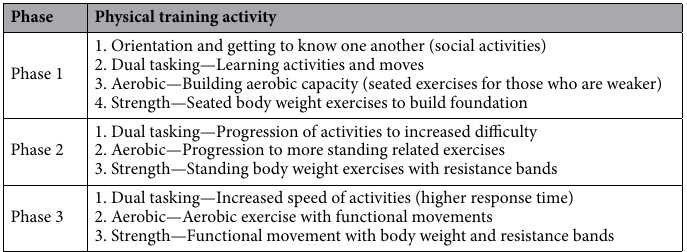
Table 1. Description of physical training protocol. Progression of phase is dependent on participants in each